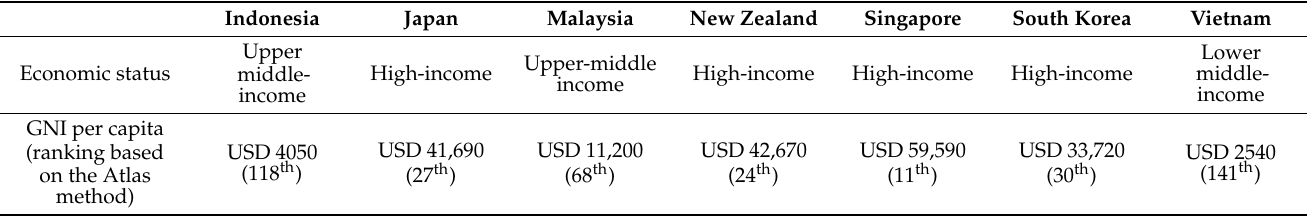
Table 10. Economic performance of the seven Asia-Pacific countries in 2019.